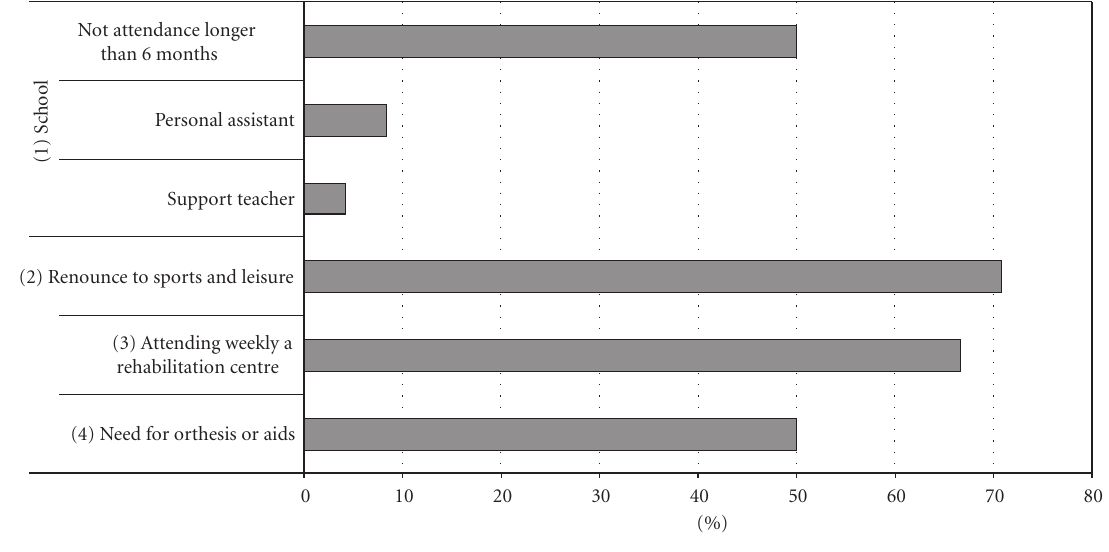
Figure 2: Quality of life.